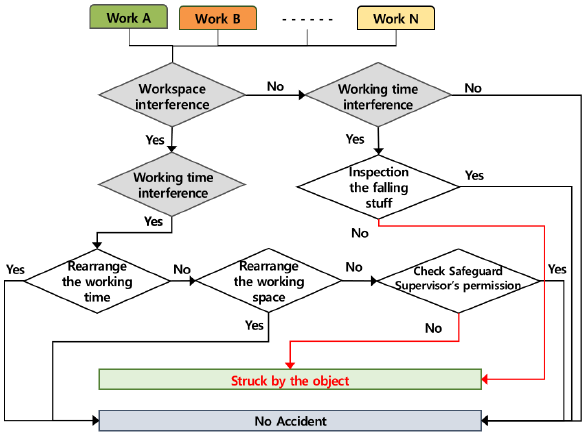
Figure 8. Mechanism of being struck by an object by multiple processes in the workplace (AMMP model for struck). 4.6. Occurring Mechanism of Being Crushed by Machinery, Equipment, Payload, etc.